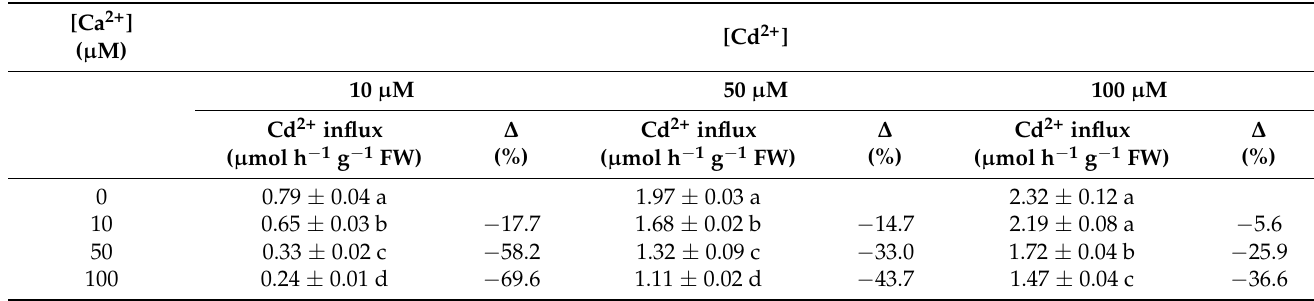
Table 1. Effect of Ca 2+ on Cd 2+ influx in subapical maize root